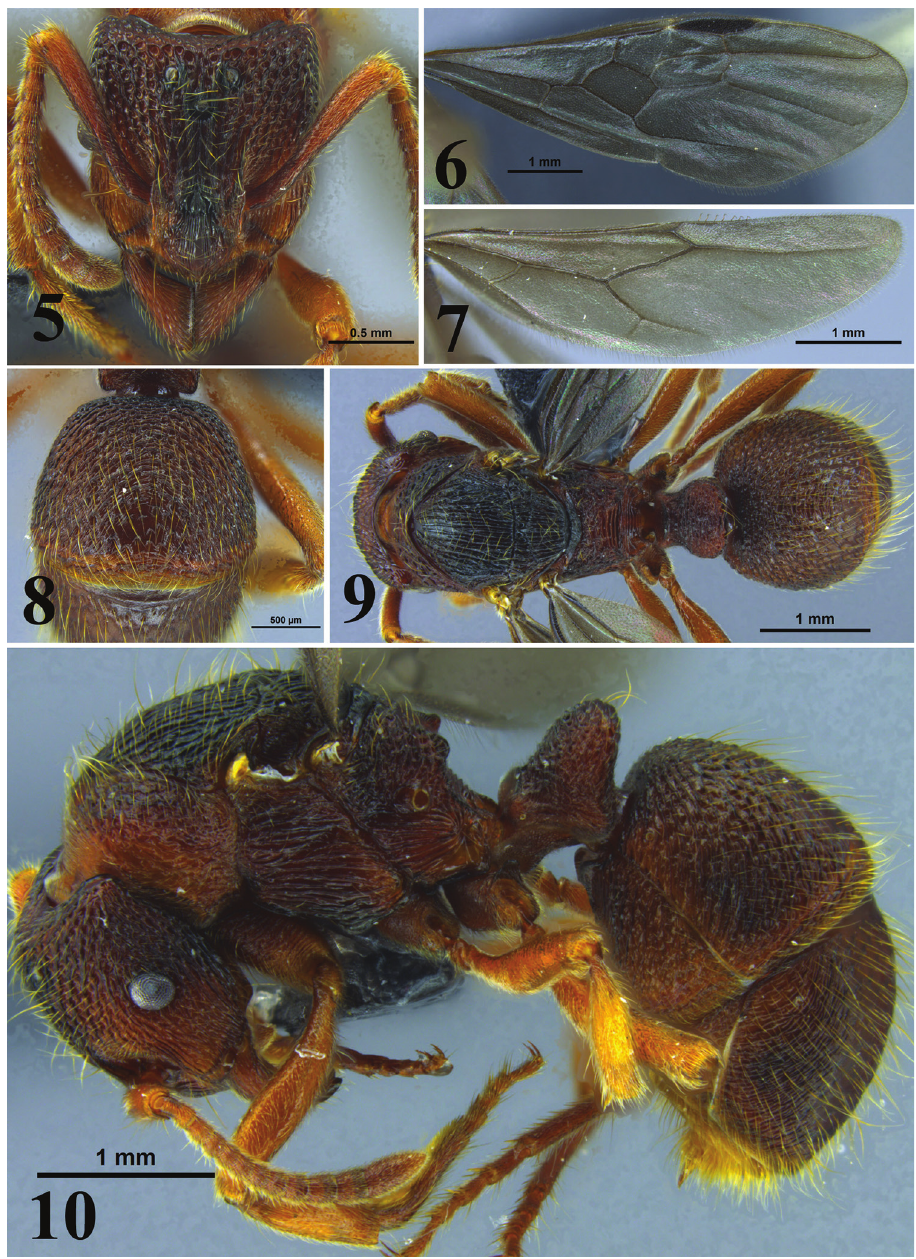
Figures 5–10. Gnamptogenys dentihumera paratype queen. 5 head in full-face view 6 forewing in dorsal view 7 hindwing in dorsal view 8 gaster in dorsal view 9 body in dorsal view 10 body in lateral